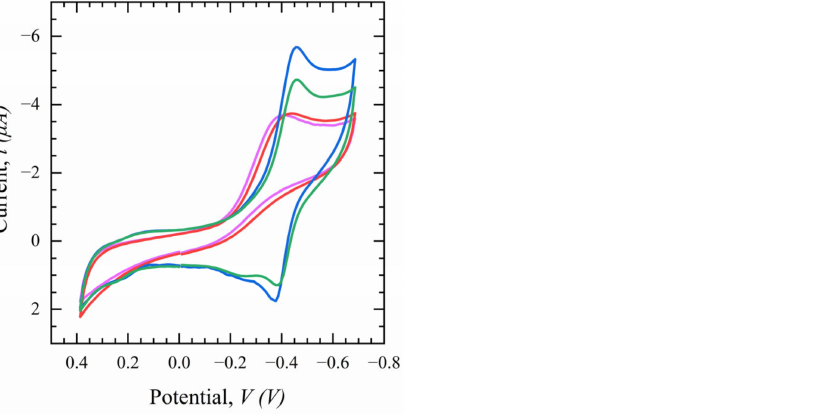
Figure 6. Cyclic voltammetry (CV) of the modified electrode in the presence of PBS 0.1 M. (Red: bare sensor, purple: CNT-COOH, blue: CNT-COOH/Th + GNp, green: CNT-COOH/Th + GNP/Ab), ( n =